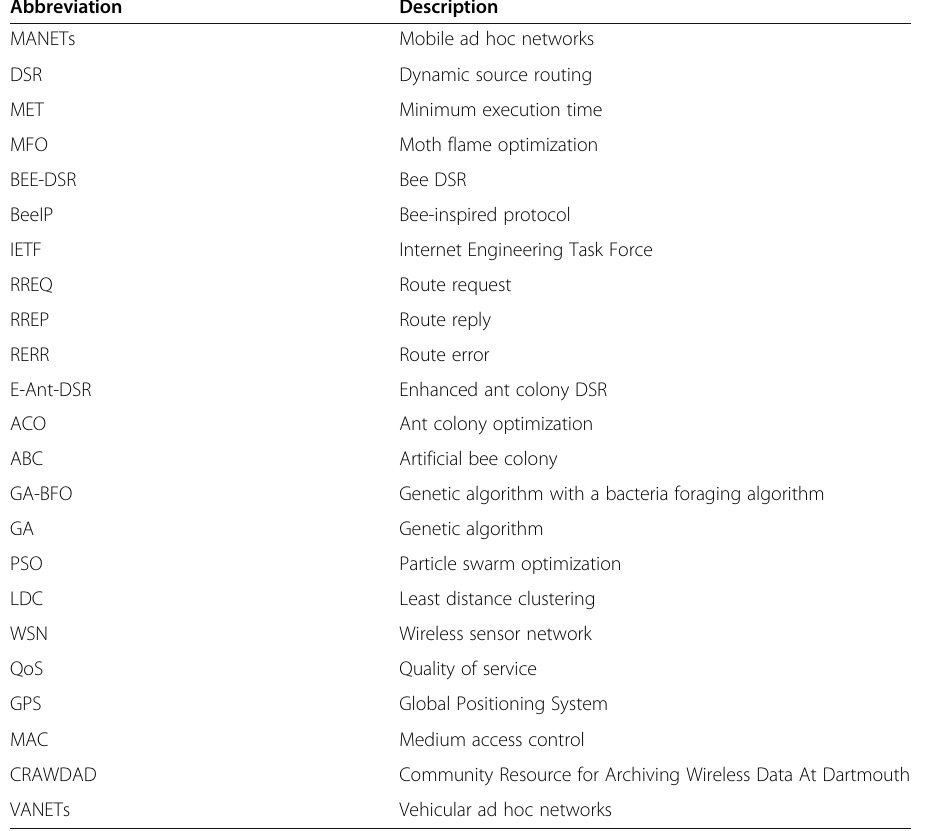
Table 1 List of